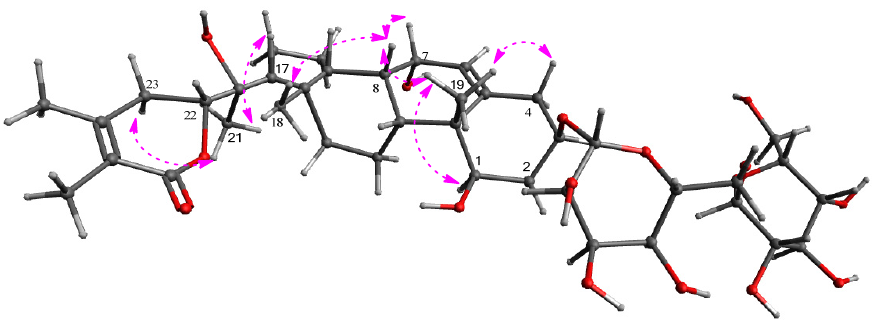
Figure 4. Key ROESY correlations for 1 .